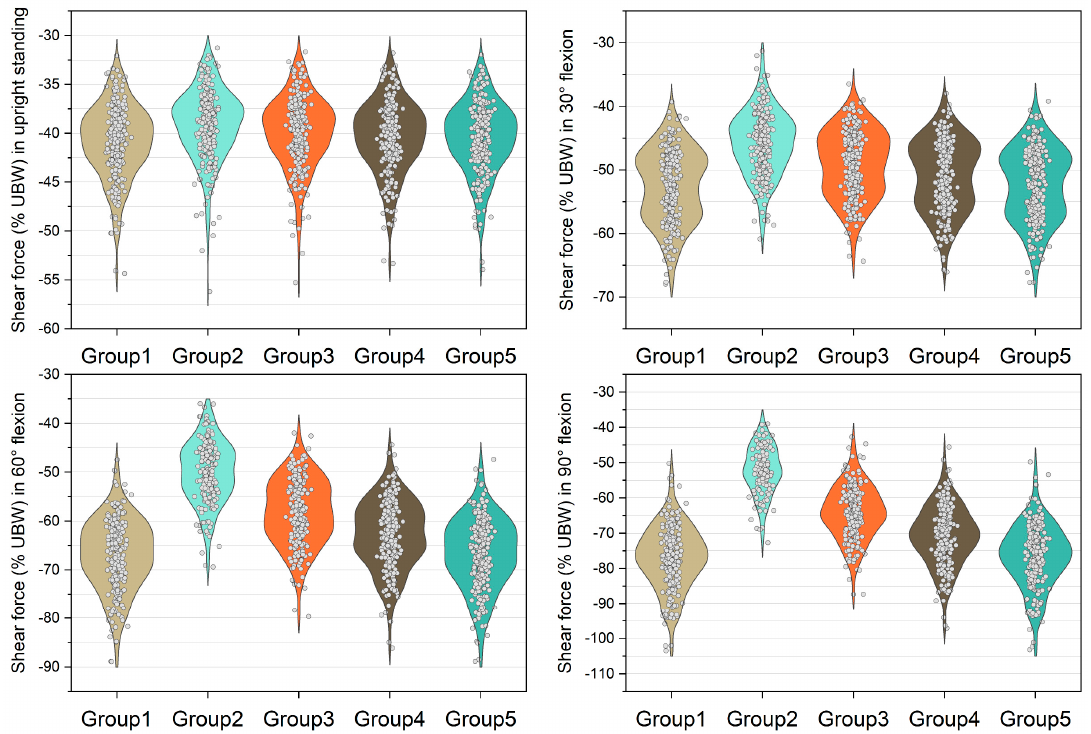
Figure 6. Normalized shear force expressed by % upper body weight (%UBW) on the L4/L5 level. The grey circle denotes the value computed by each sample in each group.